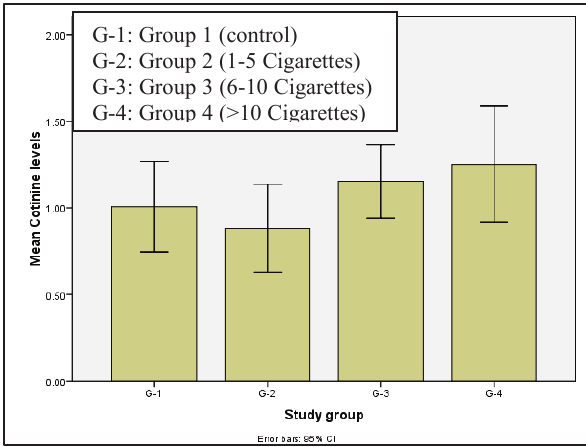
Fig-1: Mean Cotinine Level (ng/ml) of all four groups with standard